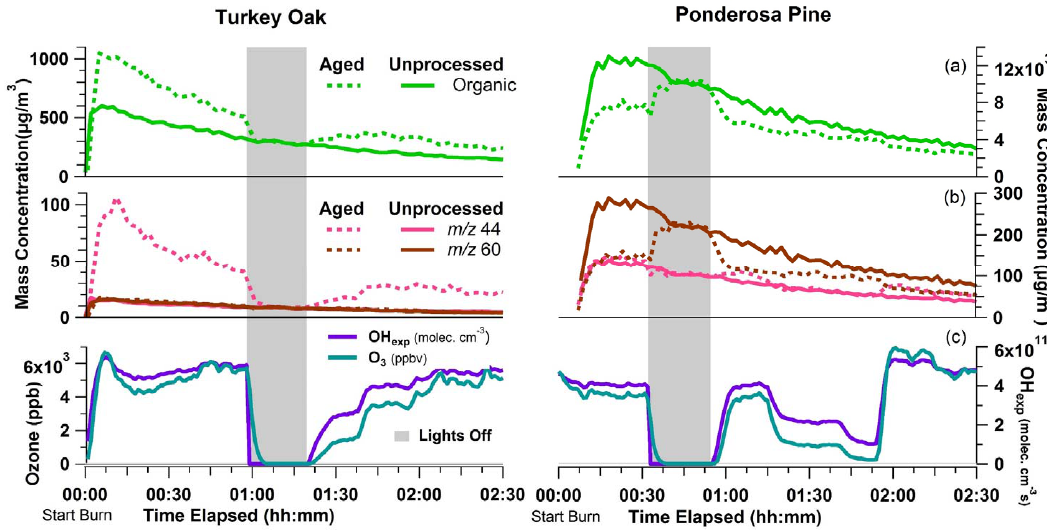
Fig. 5. Time series of OA data for turkey oak (burn 45) and ponderosa pine (burn 40) smokes. (a) OA mass concentration, (b) oxidation marker ( m/z 44) and primary biomass-burning marker ( m/z 60), (c) O 3 and OH exposure. The gray boxes denote a period when the UV lights in the flow reactor are turned